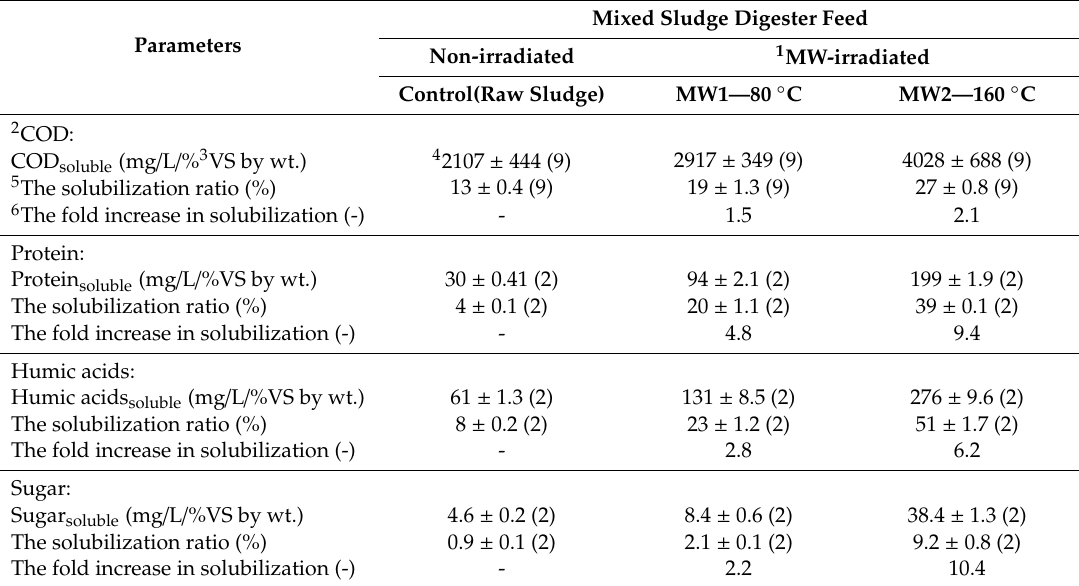
Table 4. E ff ect of MW pretreatment on mixed sludge